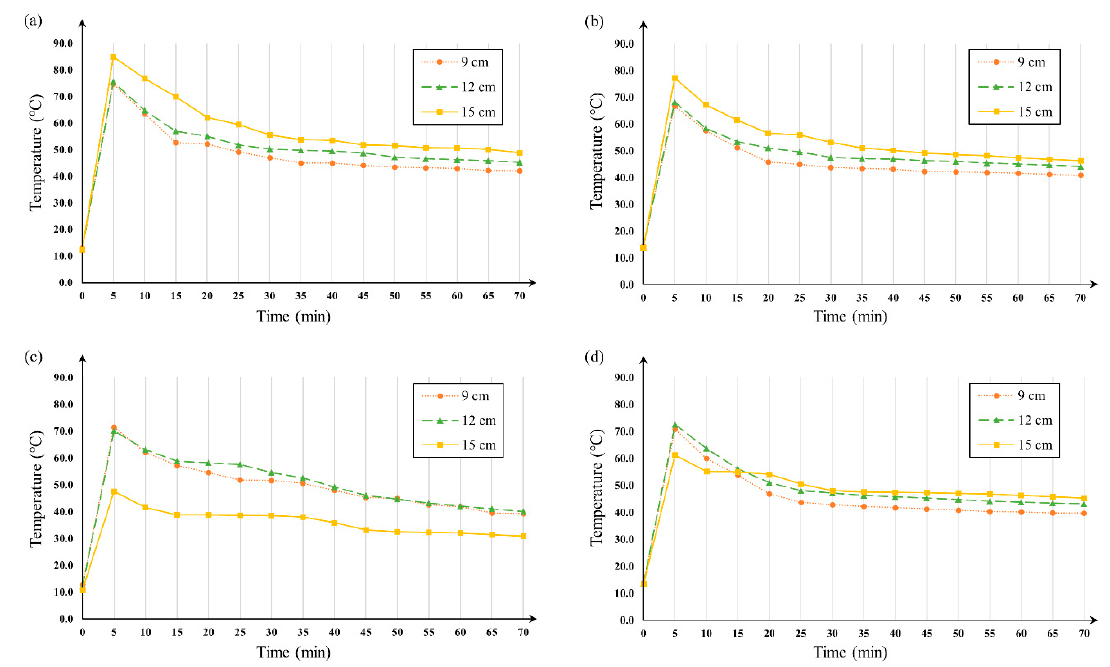
Figure 1. Temperature changes over time after steam disinfection: ( a ) 160 °C, 1 m/min, and 15 cm, ( b ) 120 °C, 1 m/min, and 15 cm, ( c ) 160 °C, 2 m/min, and 15 cm, and ( d ) 160 °C, 1 m/min, and 9 cm. Table 1. Results of the level setting of the target parameters for the Box − Behnken design.